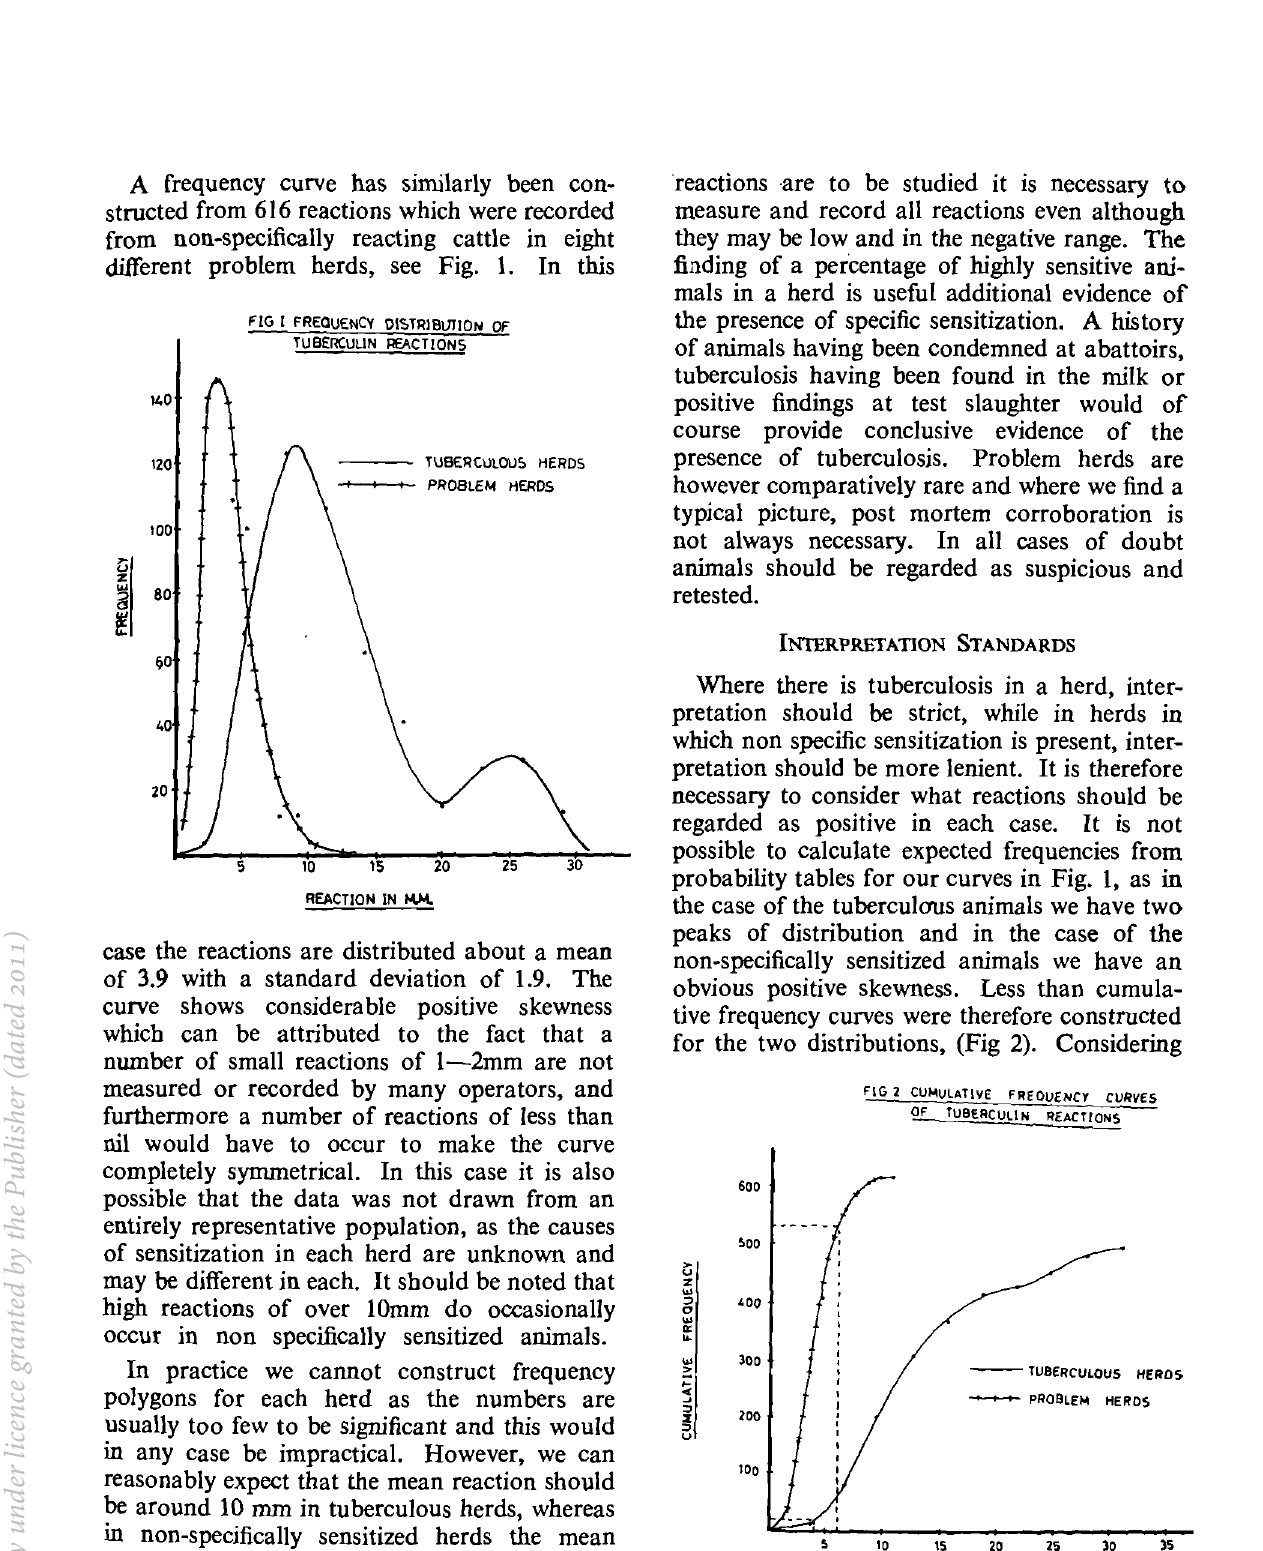
--- TUBERClJLOUS HERD5 I I I PROBLEM HERDS